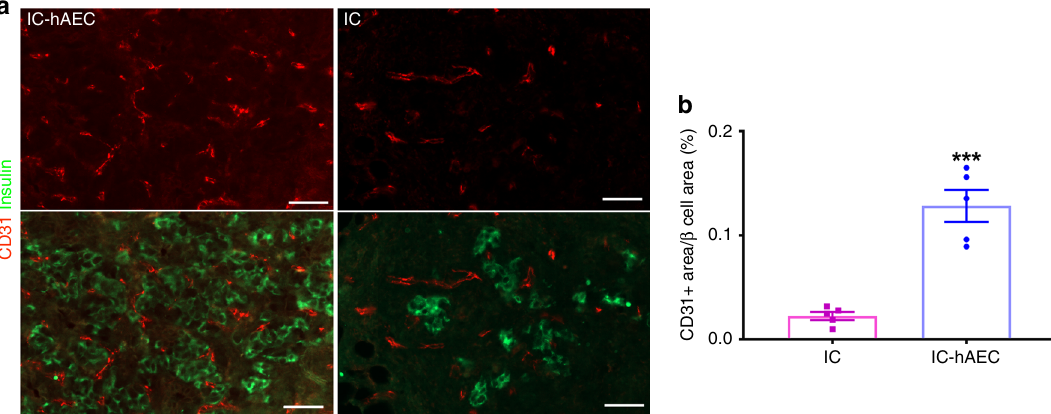
Fig. 9 Revascularization of the grafts transplanted in the epididymal fat pad. a Fluorescent images of the grafts stained for blood vessels (CD31, red) and insulin (green). Scale bar = 20 μ m. b Percentage of vessels per insulin-positive area. *** p < 0.0002 vs IC group, unpaired Student ’ s t test, n = 5. All data shown are mean ±